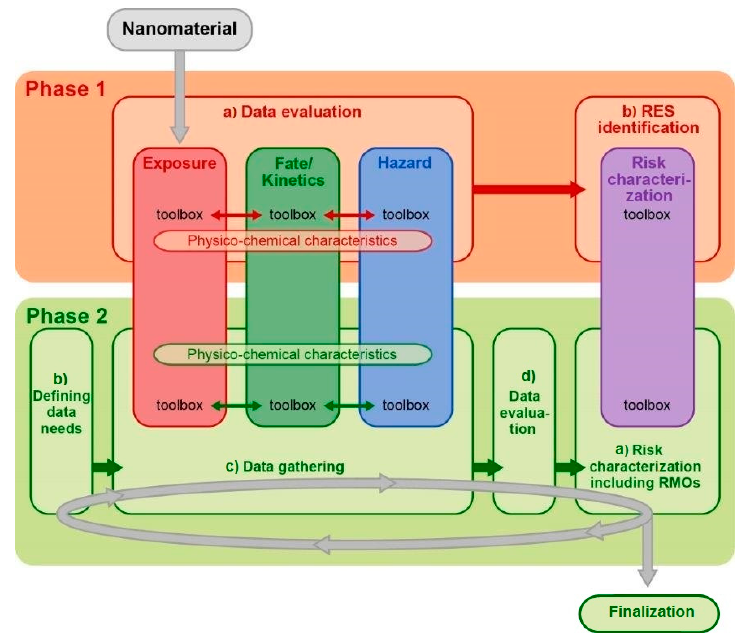
Figure 2. Schematic view of the three information-gathering pillars on the left and the risk characterization pillar on the right and their placing in the respective phases and steps of the MARINA Risk Assessment Strategy.